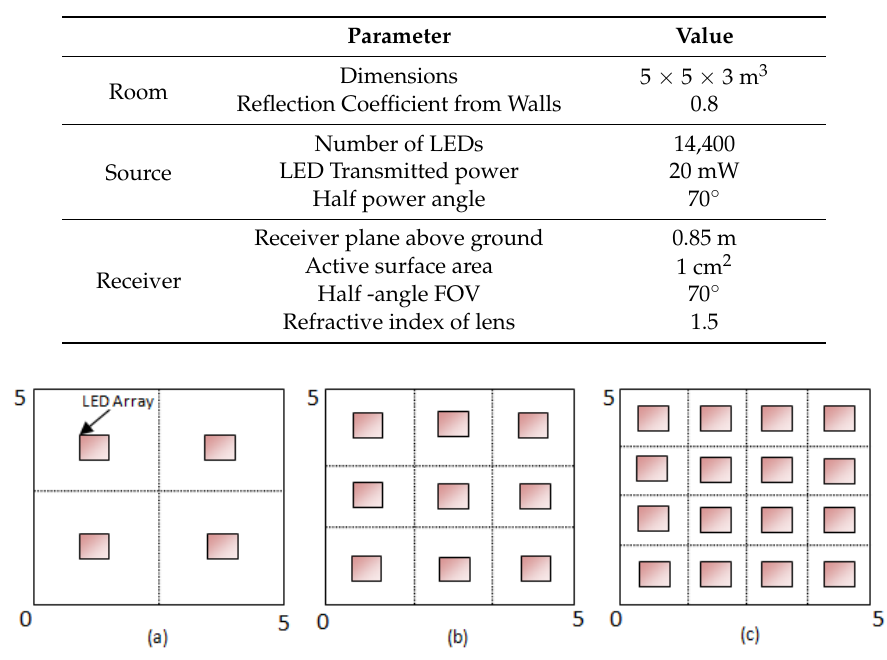
Table 1. Visible light communication (VLC) System Parameters.